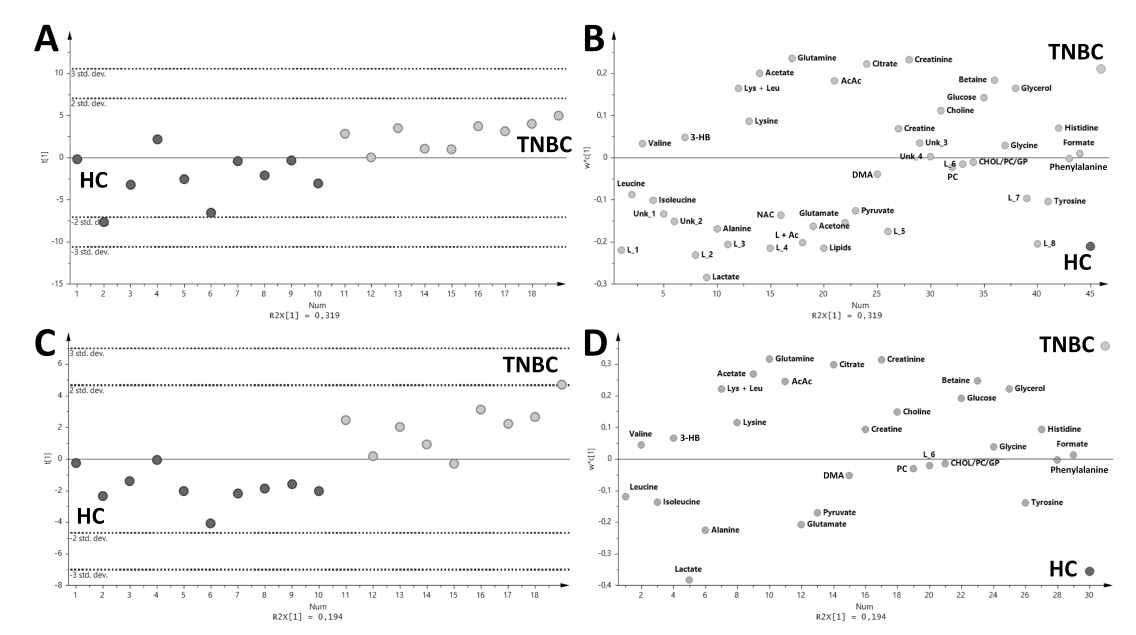
Figure 1. The PLS-DA score ( A , C ) and loadings ( B , D ) plots for triple-negative breast cancer patients (TNBC, light gray) and healthy control (HC, gray). ( A , B ) PLS-DA models with all variables used in the analysis (R2X = 0.194, R2Y = 0.69 and Q2 = 0.438, CV-ANOVA, p < 0.05). ( C , D ) PLS-DA models without